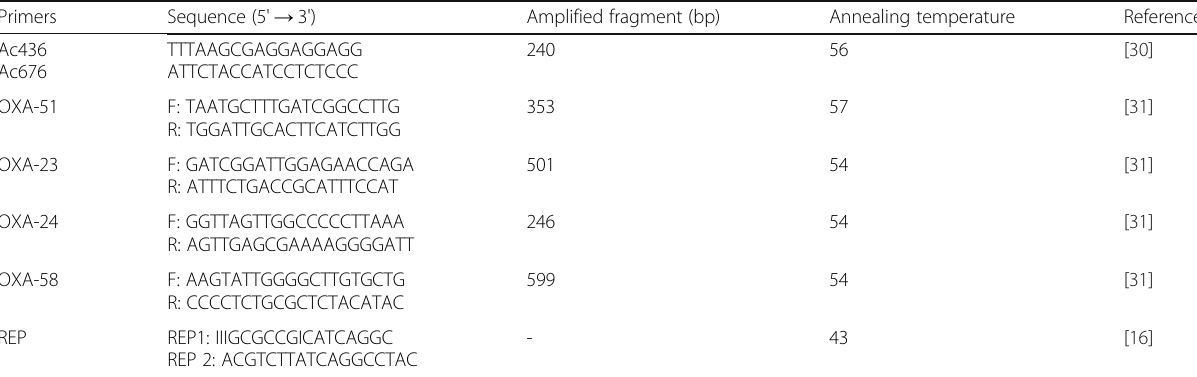
Table 1 Primers used in the study Primers